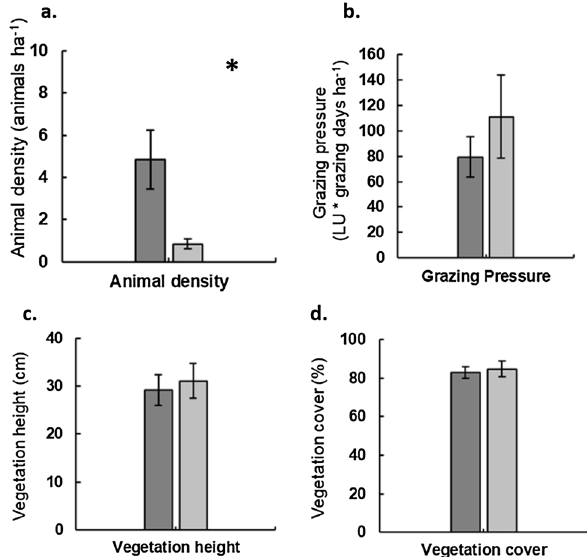
Figure 3. Comparison between sheep (dark grey) and cattle (light grey) grazed parcels for ( a ) Grazing pressure (LU * grazing days/ha); ( b ) Animal density (animals/ha); ( c ) Vegetation height (cm); ( d ) Vegetation cover (%). Values represent average and 95% confidence intervals (shown as vertical black lines). *Highlights significant